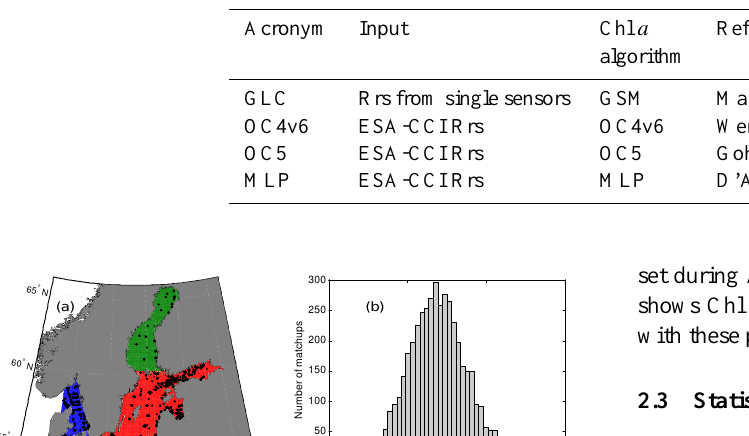
Table 1. Summary of the algorithms used in the validation analysis with the acronym used in this work along with the required input for each of them. GLC stands for GlobColour, OC4v6 for Ocean Colour four-band algorithm (version 6), OC5 for Ocean Colour five-band algorithm, and MLP for multi-layer perceptron.